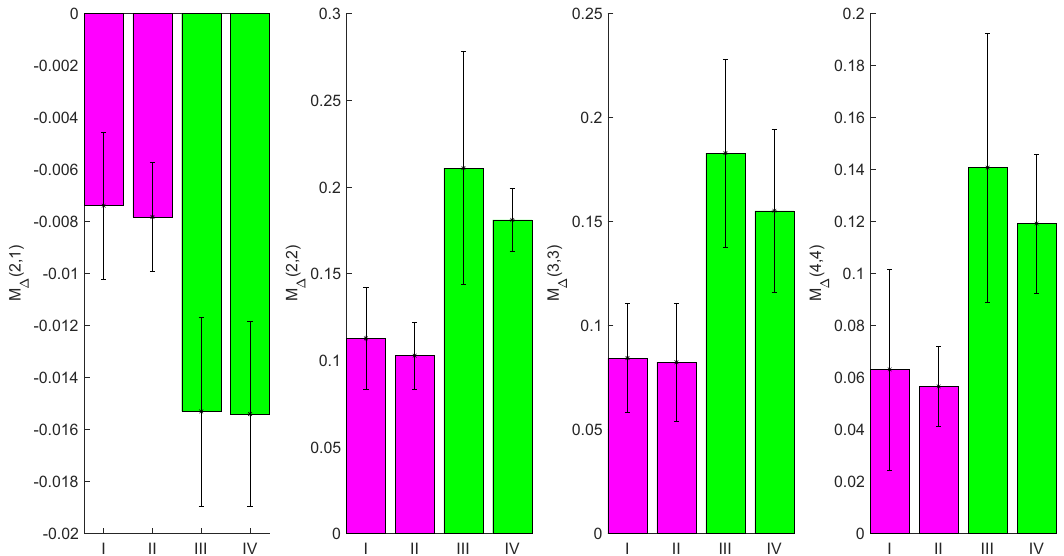
Figure 8. Mean values of M ∆ from the blue region of porcine cornea images. The errorbars represent the standard deviation for the sample size used, as derived from multiple measurements. Elements M ( 2,1 ) , M ( 2,2 ) , M ( 3,3 ) and M ( 4,4 ) show the difference between the samples with and without riboflavin